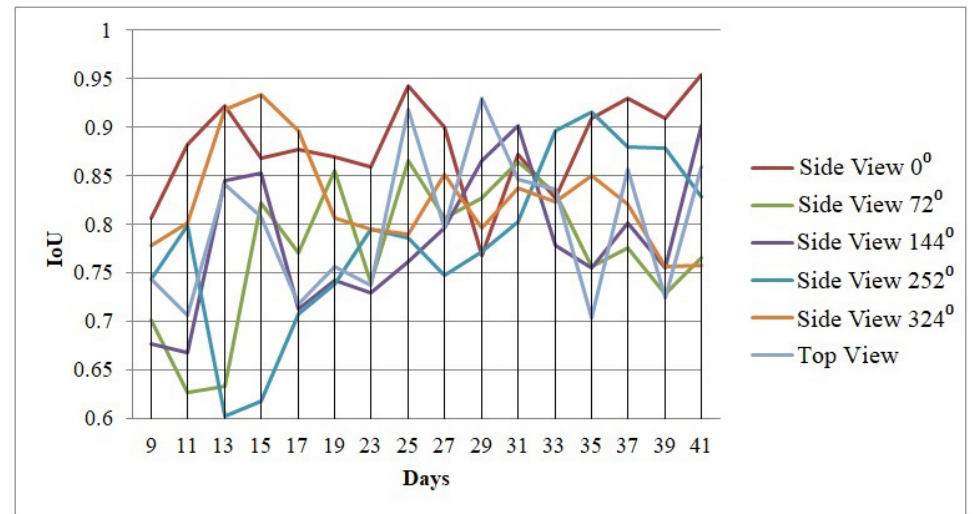
Figure 10. Performance analysis using IoU for a coleus image sequence for multiple views (Plant-ID: Coleus-D1).